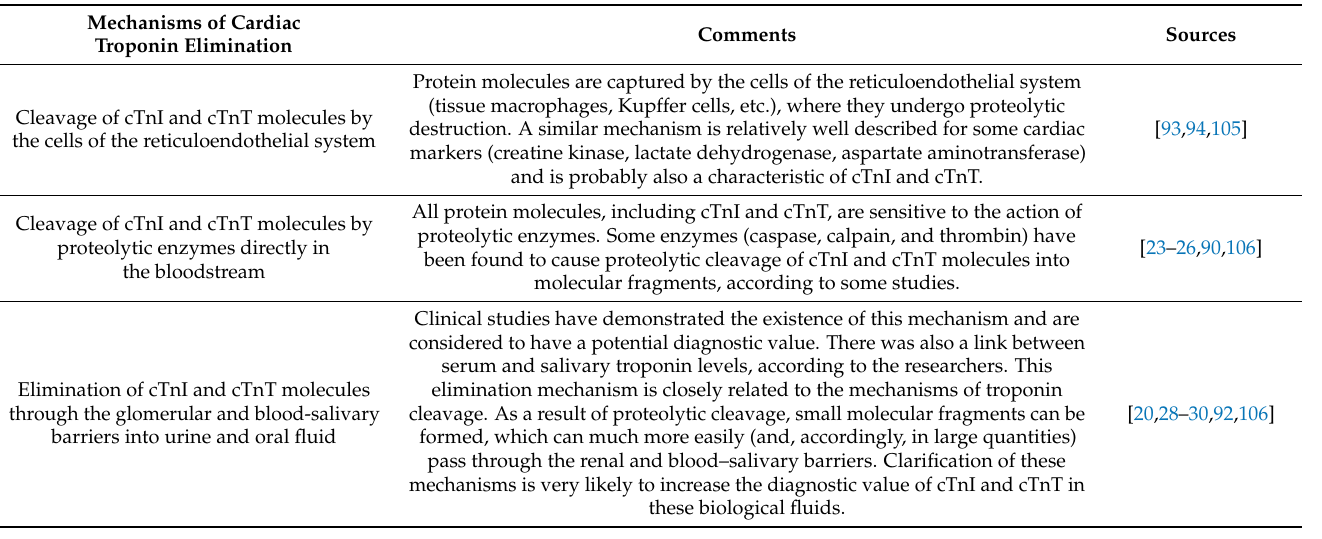
Table 2. Mechanisms of elimination of cardiac troponins from the